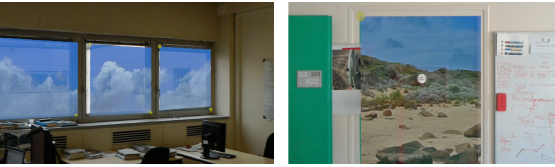
Figure 8. See-through experiments: better weather simulation through 3 portals placed at the windows (left), desert landscape through a door